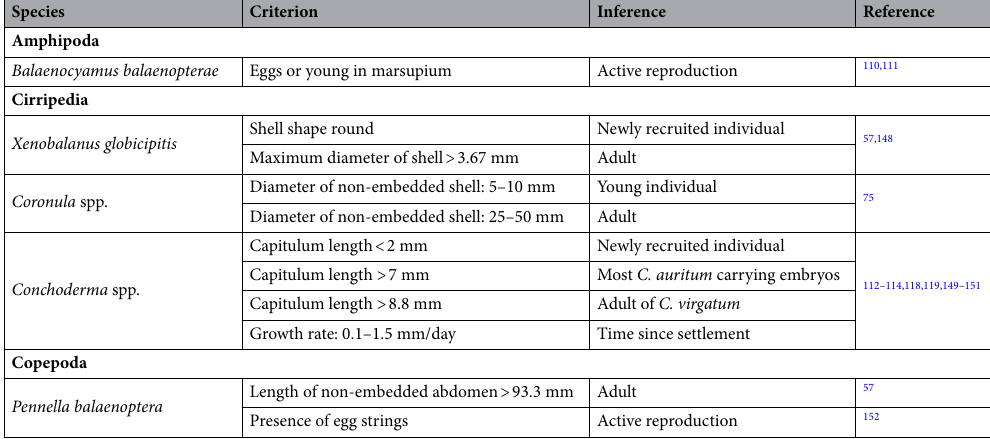
Table 1. Empirical criteria used to estimate recruitment or reproduction of the epibiotic fauna found on Antarctic minke whales, Balaenoptera bonaerensis , in the Southern